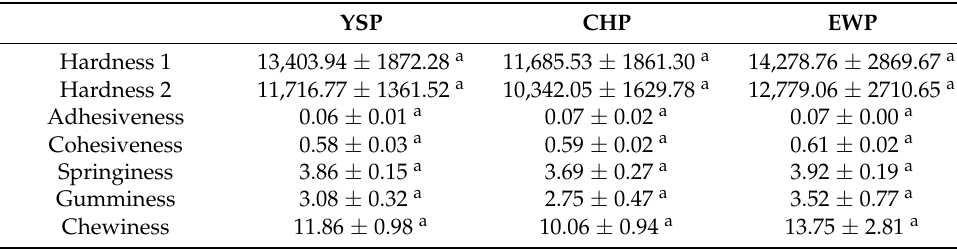
Table 4. Texture of aquasoya muffins formulated with yellow soybean powder (YSP), chickpea powder (CHP), and egg white powder (EWP). YSP CHP EWP